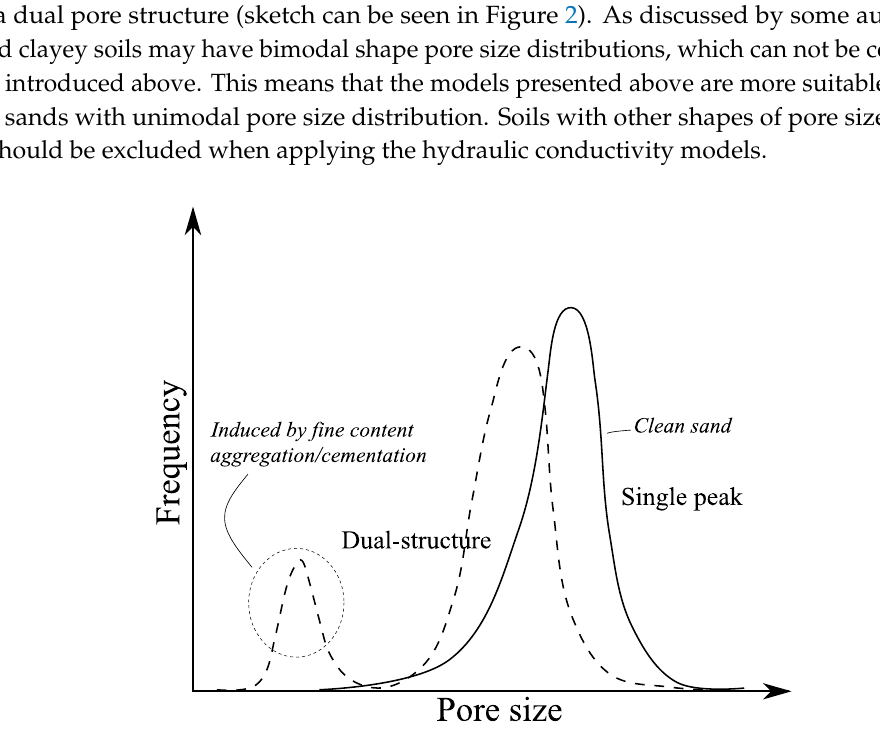
Figure 2. Sketch of the fine content effect which may change the pore size distribution to a dual-